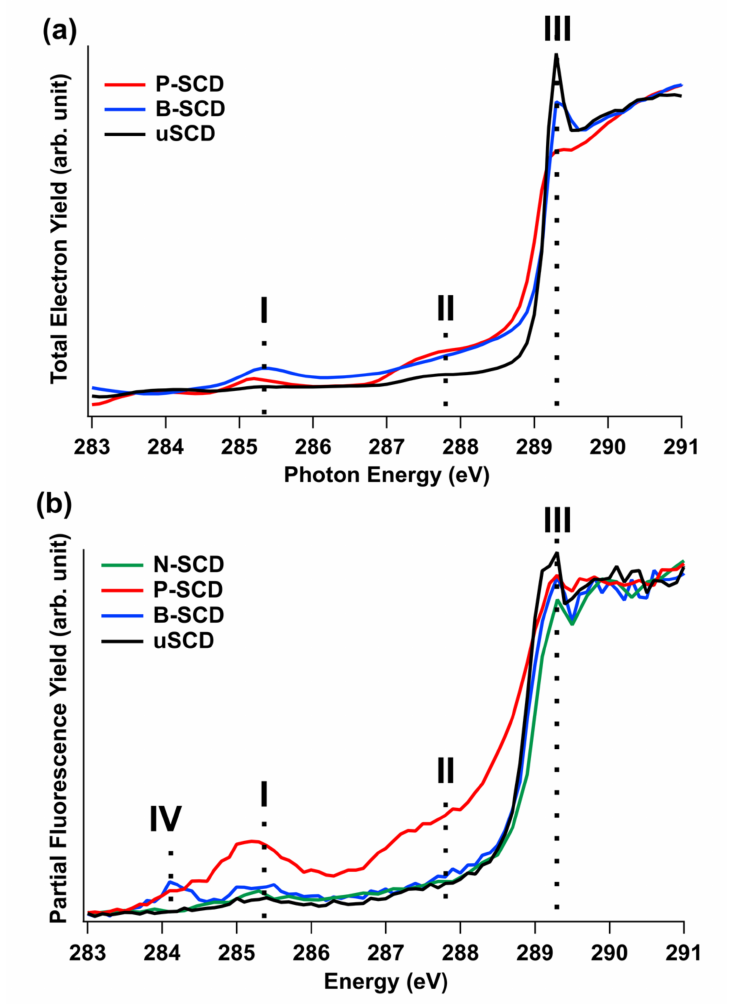
Figure 2. ( a ) TEY-XAS and ( b ) partial fluorescence yield-X-ray absorption spectroscopy (PFY-XAS) at the carbon K-edge of uSCD (black), B-doped diamond (B-SCD) (blue), P-doped diamond (P-SCD) (red) and N-doped diamond (N-SCD) (green) samples. The XA spectra were normalized to the main edge above 290